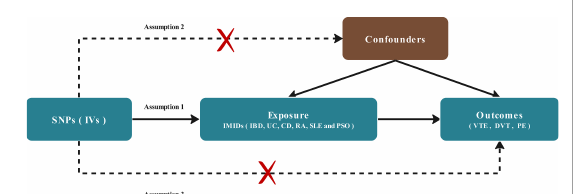
FIGURE 1 Diagram of the two-sample Mendelian randomization study for the association between IMIDs and risk of VTE/DVT/PE. IVs, instrumental variables; IMIDS, Immune-mediated in fl ammatory diseases IBD, in fl ammatory bowel disease; CD, Crohn ’ s disease; UC, ulcerative colitis; RA, rheumatoid arthritis; SLE, Systemic Lupus erythematosus; PSO, Psoriasis; VTE, Venous thromboembolism; DVT, deep vein thrombosis; PE, pulmonary